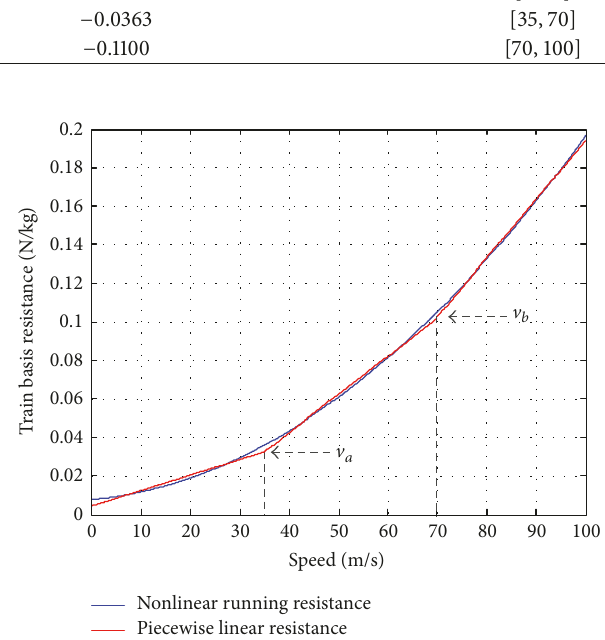
Figure 2: The piecewise linearization of train basic resistance.